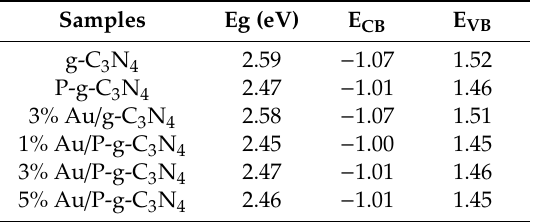
Figure 4. UV-visible absorption spectra of g-C 3 N 4 , P-g-C 3 N 4 , 3% Au/g-C 3 N 4 and different Au/P-g-C 3 N 4 samples. Corresponding band gap calculation (inset). Table 3. Band gap (Eg), relative conduction band (E CB ) and valence band (E VB ) of all obtained samples.